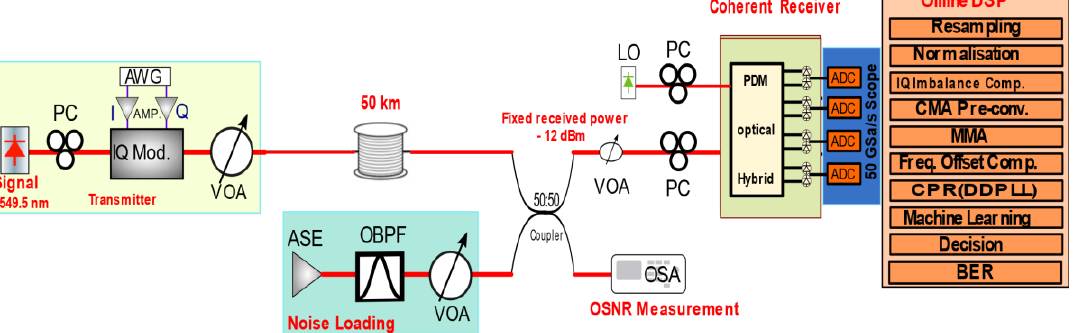
Figure 2. Experimental setup for a 40 Gb / s 16 quadrature amplitude modulation (QAM) coherent optical signal transmitted at 50 km, incorporating machine learning clustering. PC: polarisation controller, OBPF: optical band-pass filter, LO: local oscillator, CMA / MMA: constant / multi-modulus algorithm, CPR (DDPLL): carrier phase recovery (decision-directed phase-locked loop).